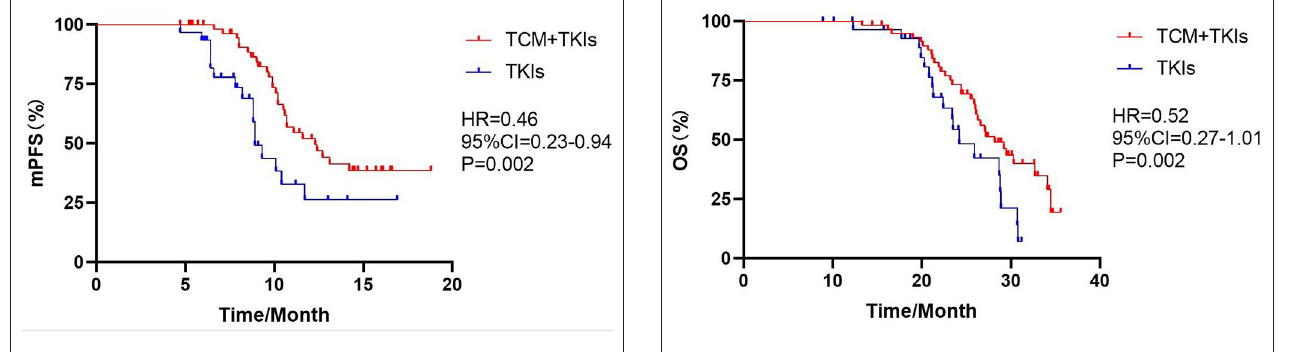
FIGURE 4 | Comparison of mOS by two groups.